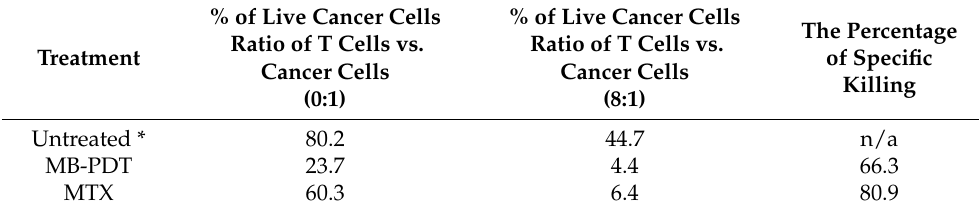
The Percentage of Specific Killing